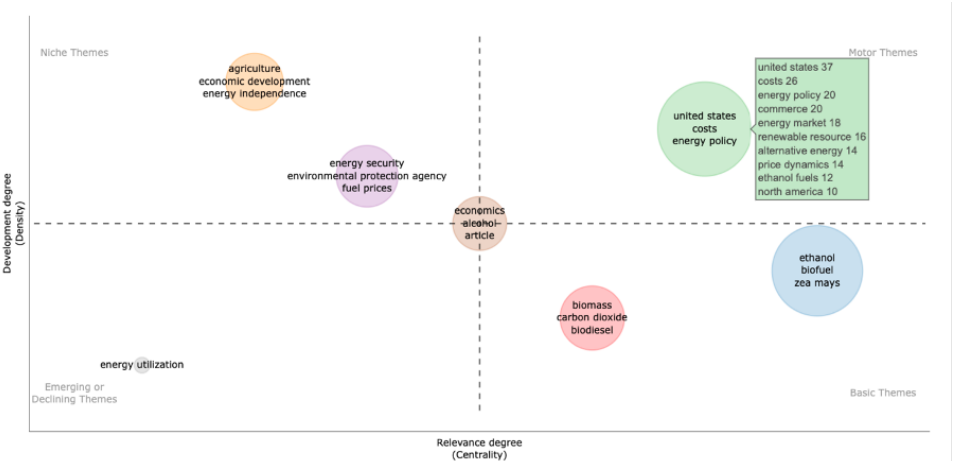
Figure 10. Thematic map (development degree × relevance